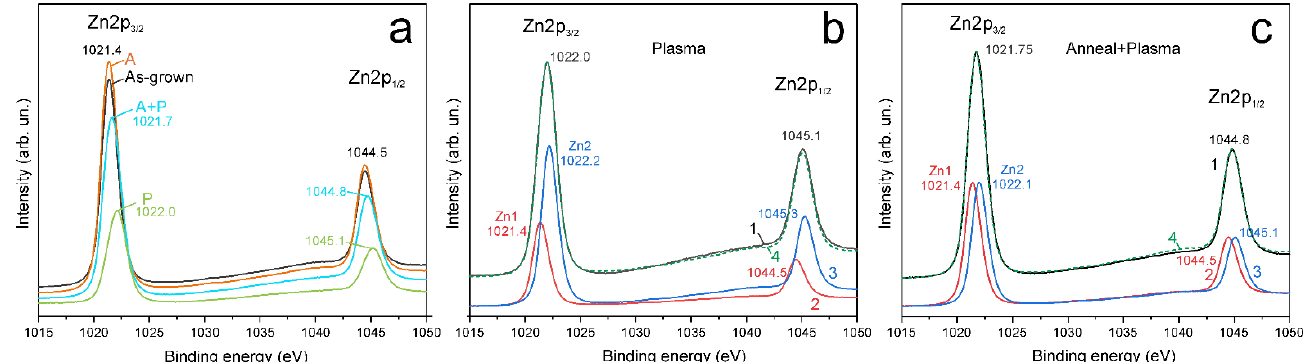
Figure 4. XPS Zn2p spectra of ZnO samples: ( a ) as-grown, annealed (A), H-treated (P), and annealed with subsequent H-treatment (A + P); ( b ) P-sample spectrum (black line); ( c ) A + P sample spectrum (black line); ( b , c ) also shown red line— Zn1 (2) and blue line—Zn2 (3) with relative intensities shown in Table 1, the green dashed line (4) on b and c is the sum of the Zn1 and Zn2 spectra. Table 1. Parameters of XPS Zn2p spectra of the